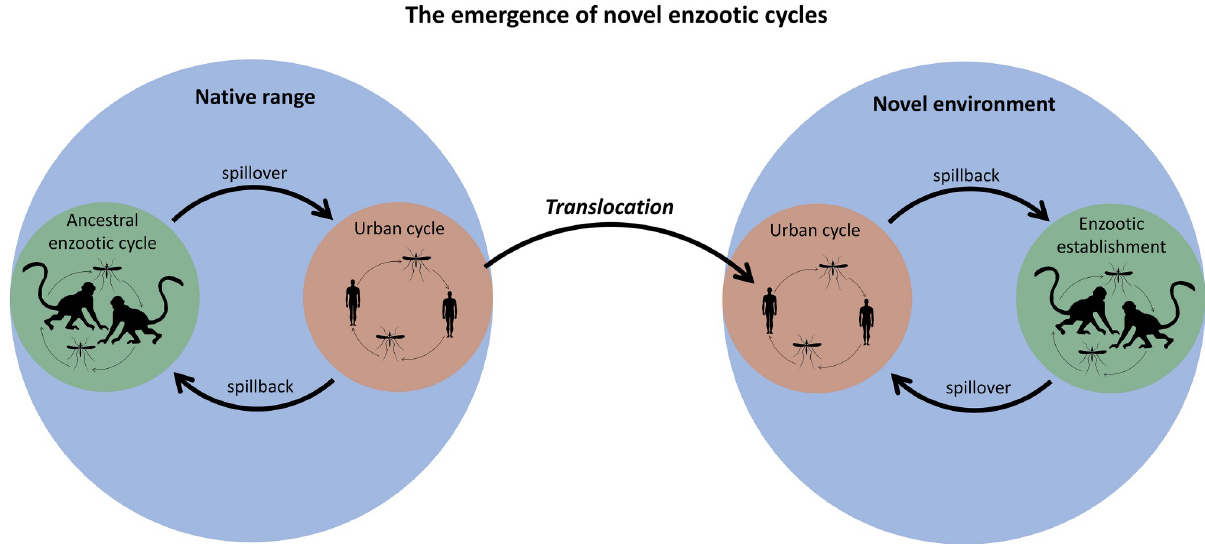
Fig 1. A diagram of the processes by which novel enzootic cycles emerge.